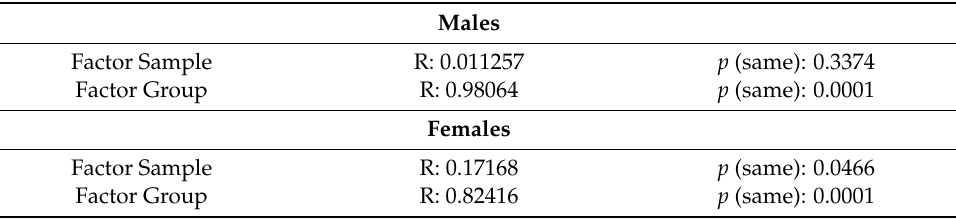
Figure 3. Graphic representation of morphometric heterogeneity of the Acanthopharynx individuals from the joint sample of PA13 and PA21 sponge specimens. ( A , B )—multidimensional analysis, discrimination of two assemblages of males ( A ) and females ( B ) from samples PA13 (circles) and PA21 (squares) belonging to groups Acanthopharynx 1 ( black ) and Acanthopharynx 2 (red). ( C , D )—principal component analysis of two assemblages of males ( C ) and females ( D ) from samples PA13 (circles) and PA21 (squares) belonging to groups Acanthopharynx 1 ( black ) and Acanthopharynx 2 (red). Table 3. The results of Two-way Analysis of Similarities (ANOSIM) for males ( n = 53) and females ( n = 39). Samples and groups were the same as in Figure 2. The test statistics R (tend to 1 as differences increase) and significance p were calculated using PAST